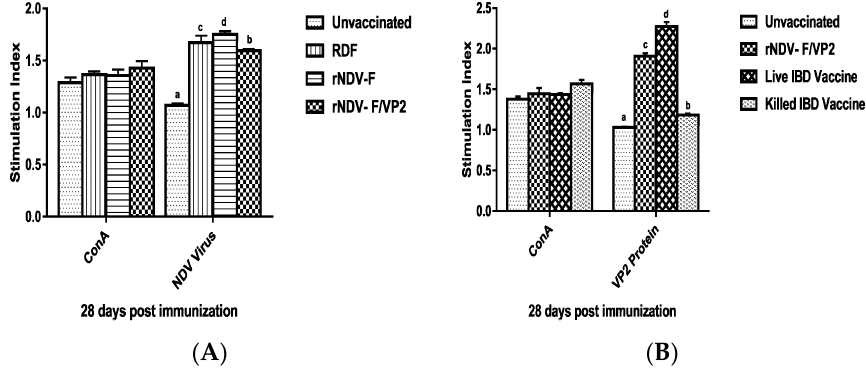
Figure 6. Antigen specific lymphocyte proliferative response in chickens on 28 days post immunization. Chicken PBMCs from immunized and control groups (n = 6) were stimulated with NDV virus ( A ), recombinant VP2 protein expressed in Saccharomyces cerevisiae ( B ), and concanavalin A (conA) as positive control. Lymphocyte proliferative response was measured and expressed as stimulation index. All the data presented as mean value ± standard error and Waller-Duncan as post-hoc test. Level not connected by same letter are significantly different ( p < 0.01).